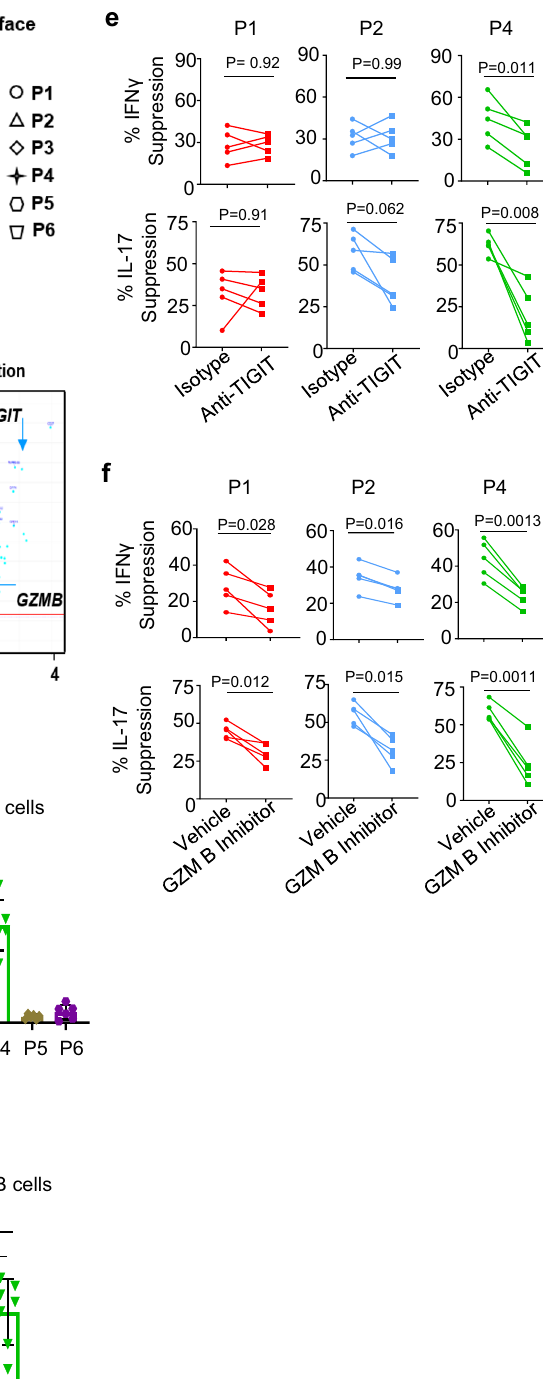
Fig. 8a, patients with serum donor-speci fi c antibody (DSA) had